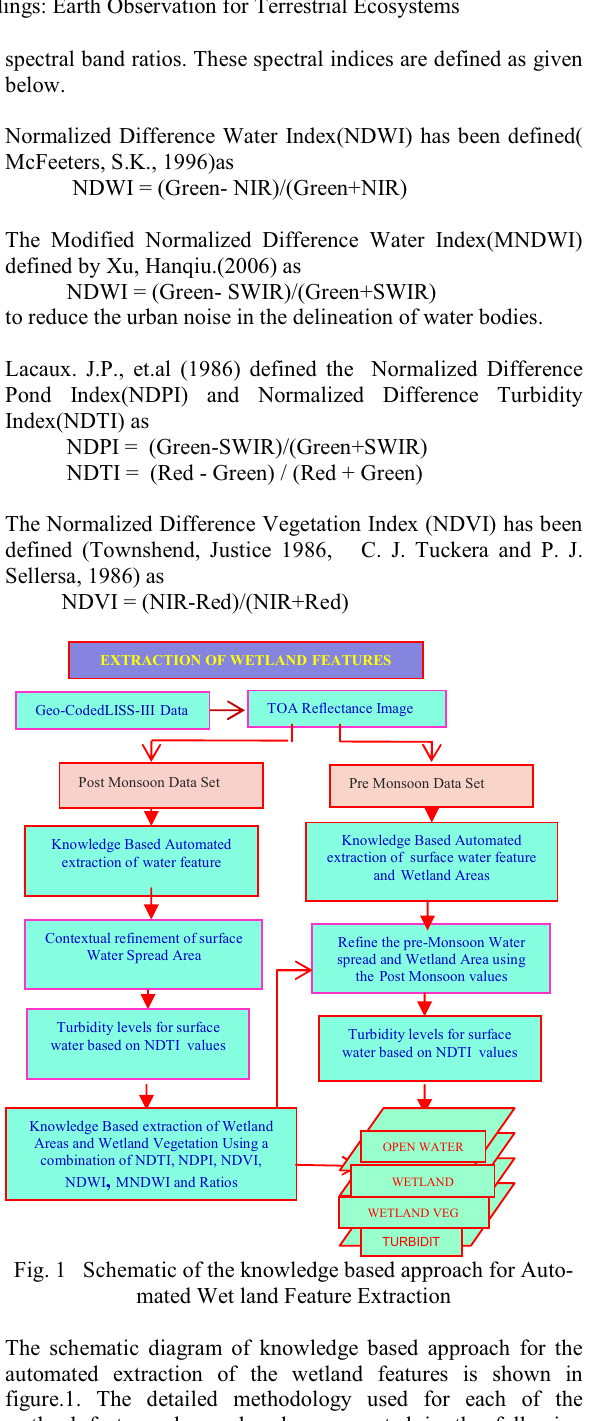
figure.1. The detailed methodology used for each of